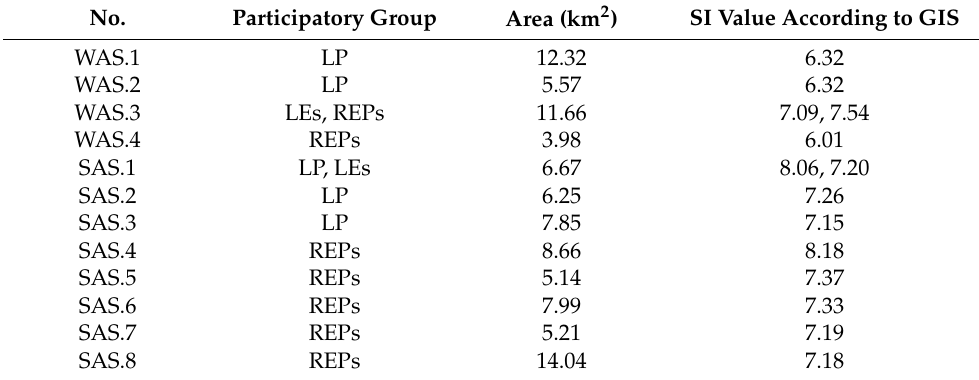
the Field Investigation module.